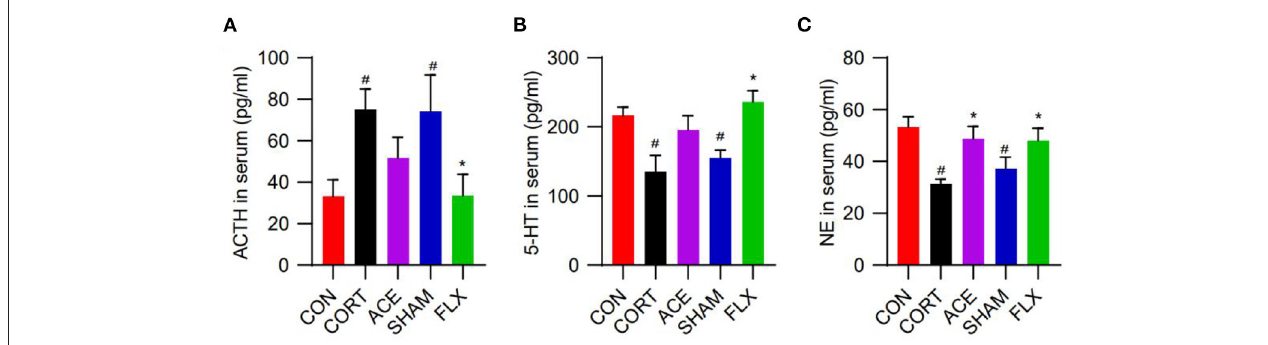
FIGURE 3 | Effect of ACE on the serum neurotransmitter levels of mice. (A) ACE decreased the serum ACTH level of mice to some degree without statistical significance ( n = 8 per group). (B) ACE increased the serum 5-HT level of mice to some degree without statistical significance ( n = 8 per group). (C) ACE significantly increased the serum NE level of mice ( n = 8 per group). Experimental values were expressed as means ± SD. # P < 0.05 compared with the CON group. * P < 0.05 compared with the CORT group.